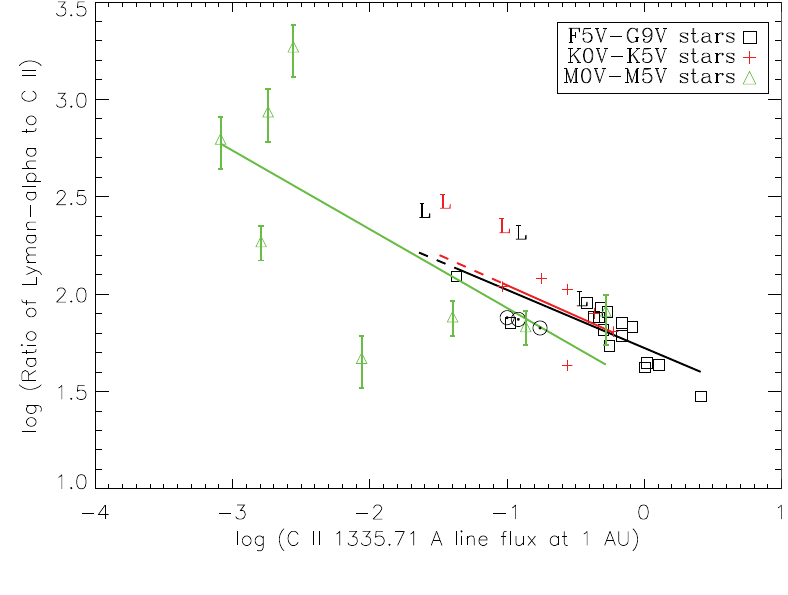
Figure 8. Plot of Lyman- α /C II 1335,1336 Å multiplet flux ratios vs . the C II flux at a distance of 1 AU from each star. The data points refer to dwarf stars and the quiet and active Sun ( (cid:12) symbols). Black squares are for F and G stars, red pluses are for K stars, and green triangles are for M stars. Solid lines are least-squares fits. Low metallicity stars are indicated by L symbols. The correlations for F–K stars are tight, whereas the correlation for M stars shows scatter larger than measurement errors likely because of the large variability of these stars and observations of Lyman- α and C II fluxes at different times. Figure from Linsky et al . with copyright permission [56].